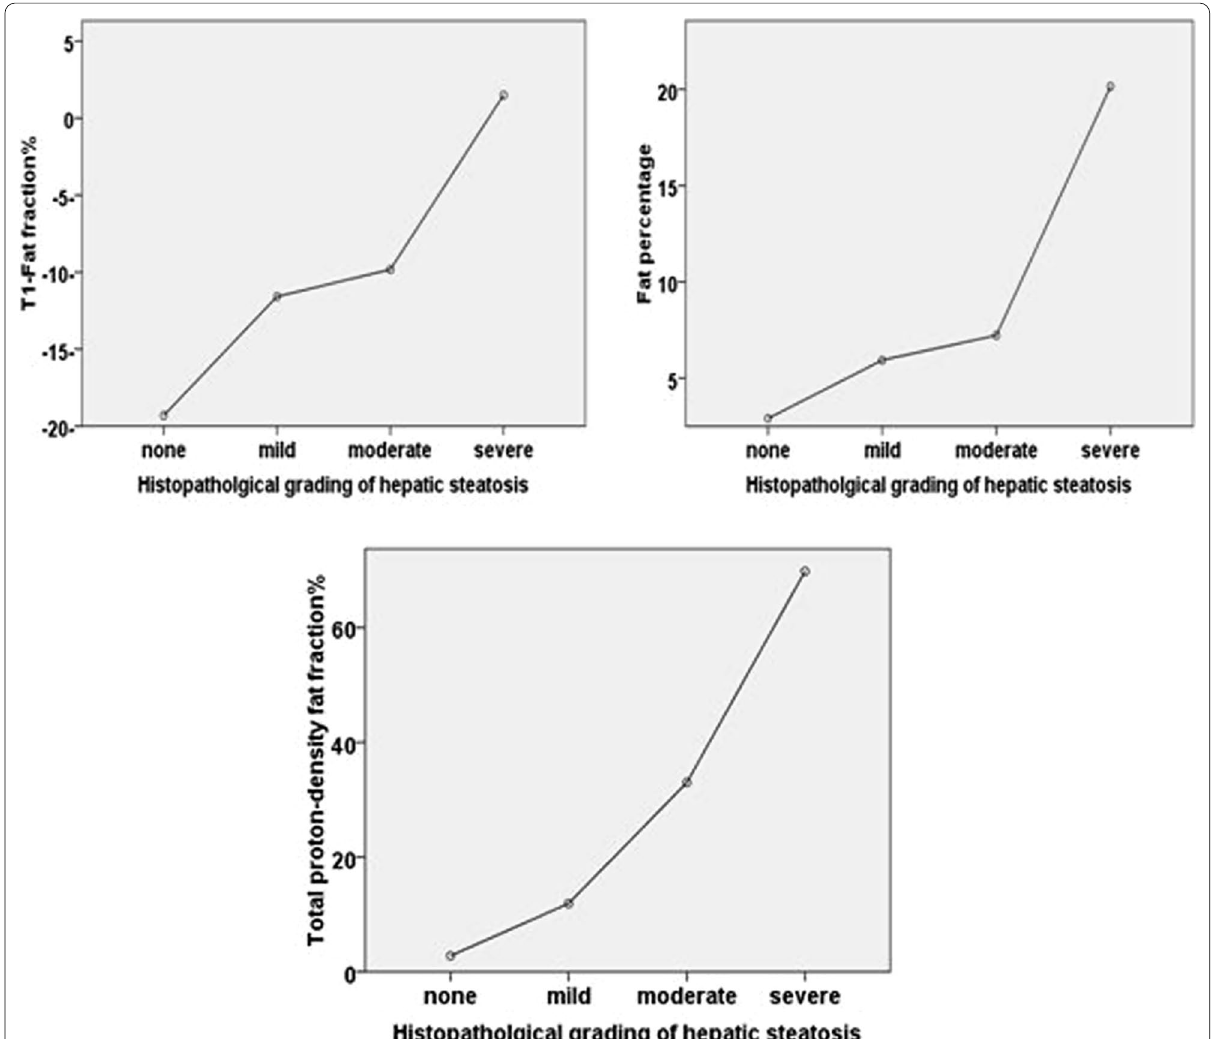
Fig. 2 Correlation between the histological hepatic steatosis grades and evaluated liver fat metrics of MRI. The figure shows increased liver fat metrics of MRI with increasing grades of